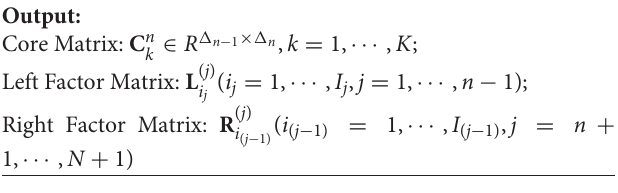
Algorithm 1: Feature Extraction based on MPS